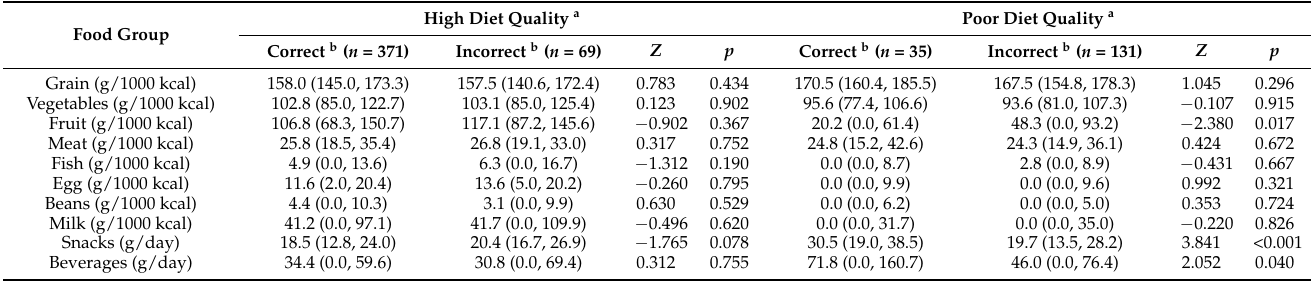
Table 4. Food consumed by each diet quality group according to diet status and caregiver’s perception (M (P25, P75)).